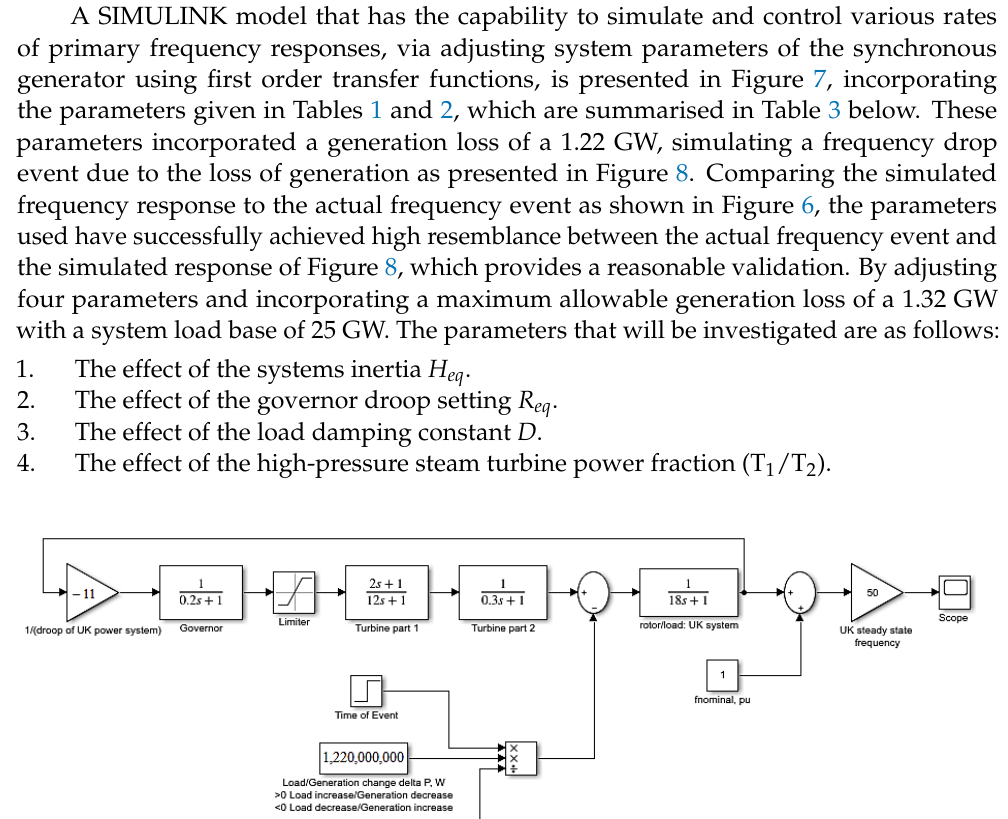
Figure 6. An actual frequency event occurred on the NG power system on 15 August 1995 (Reprinted with permission from ref. [33]).